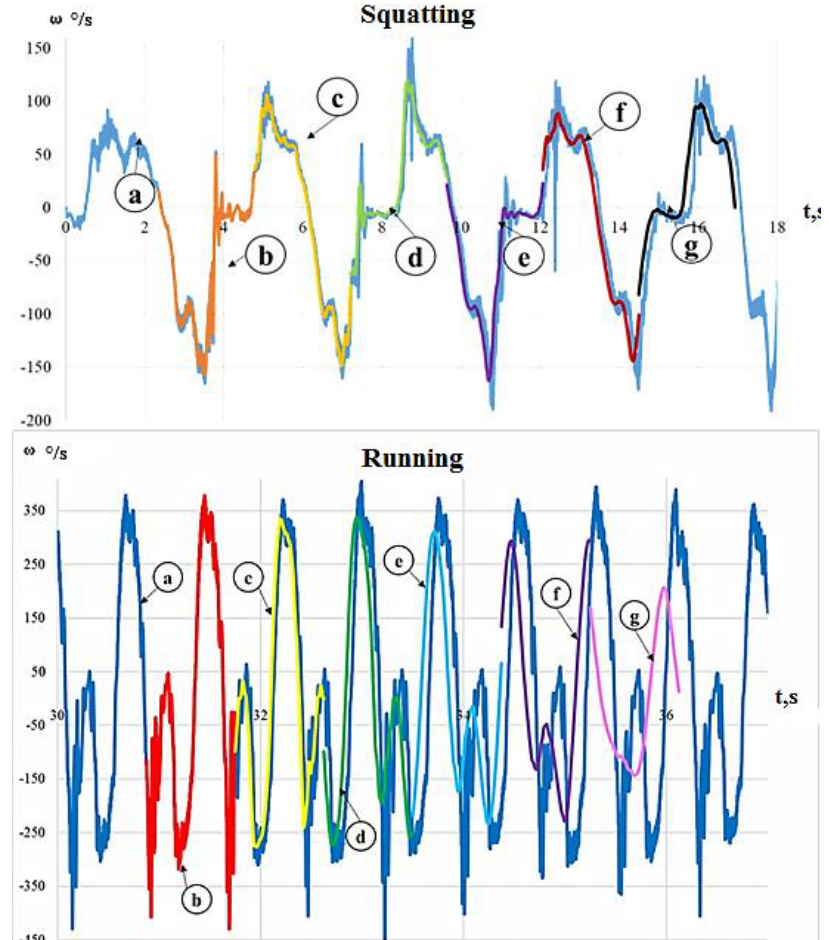
Figure 6 . Gyroscope signals for squatting and running using a sliding average filter with different window widths: a - gyroscope signal without filtration; b - window 10 points; c - window 50 points; d - window 100 points; e - window 150 points; f - window 200 points; g - window 300